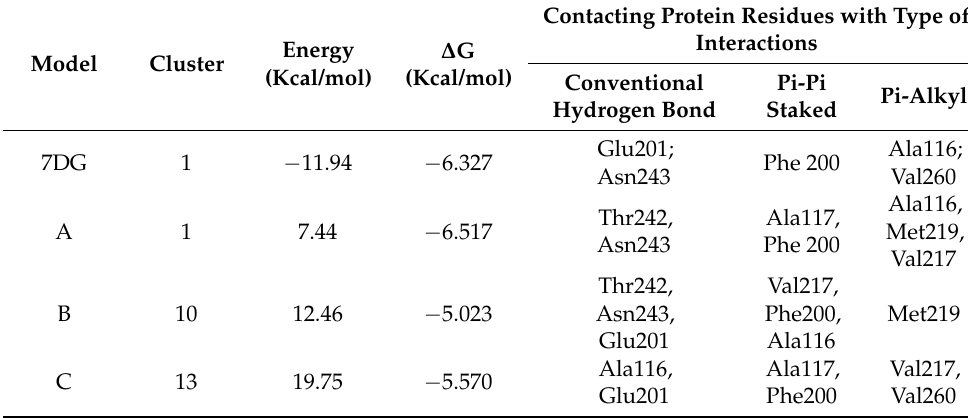
Table 2. Docking results of top-ranked poses for compound 2 . Model Cluster